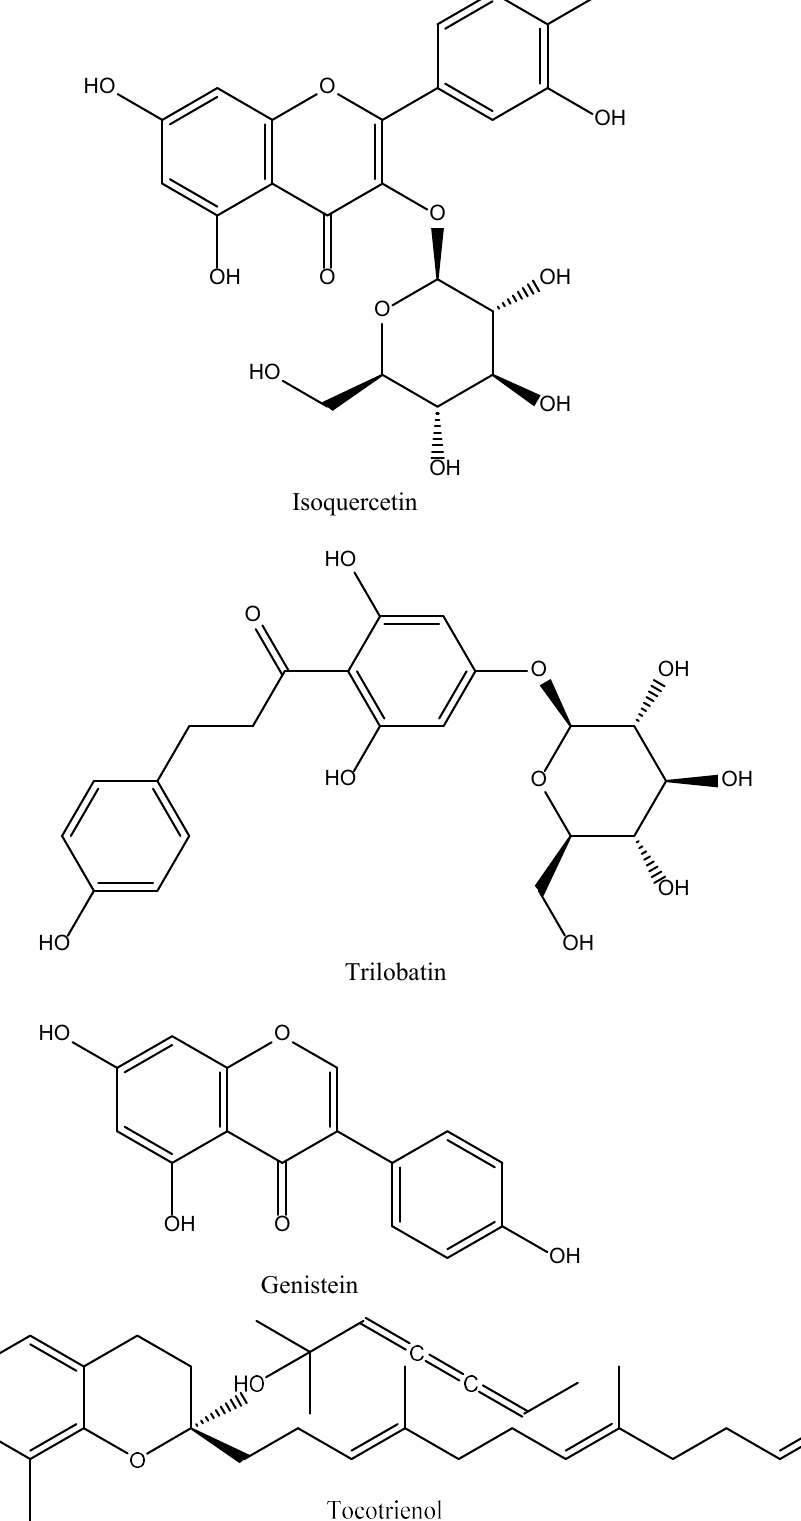
Figure 2. Promising phytocompound’s structures for stroke.